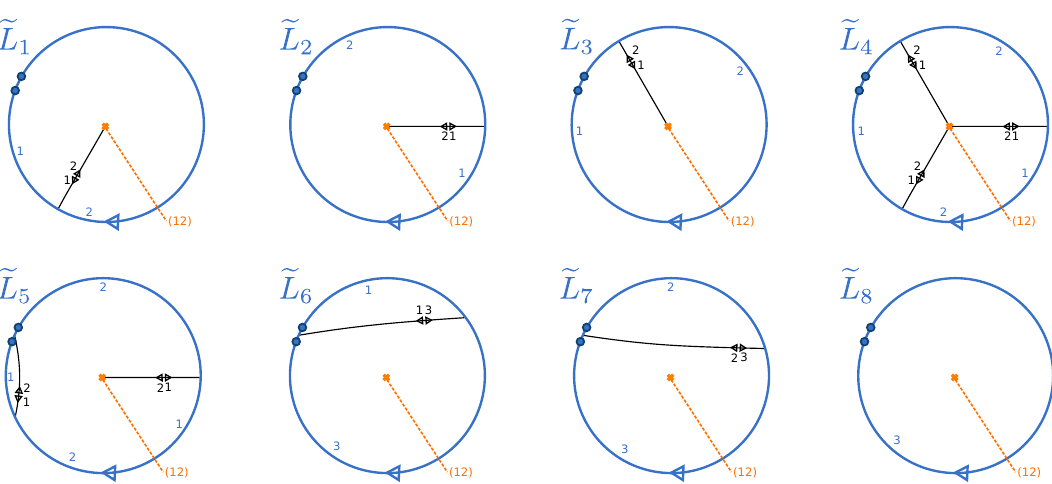
Figure 40 . The 8 lifts of the unknot L . We represent each lift e L k by specifying the sheet label for each segment of L and showing the webs which are used. Note that all the webs which are used are